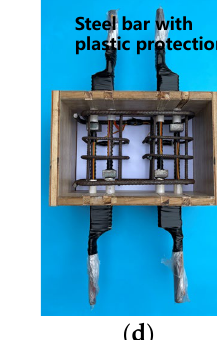
Figure 3. Production of specimens ( a ) Steel bar with head plate; ( b ) Strain gauge operation; ( c ) Mold; ( d ) Fabricated specimen.